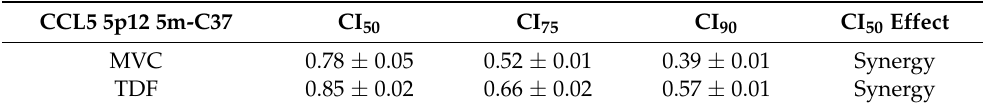
Figure 4. CCL5 5p12 5m-C37 drug combinations. HIV-1 BaL inhibition was evaluated by acute infection assays as described in Figure 3A. CCL5 5p12 5m-C37 was tested in combination with MVC ( A ) and TDF ( B ). The dose-response curves of mixed inhibitors (mix) are referred to CCL5 5p12 5m-C37 ( p -values < 0.0001). Values indicate the means ± SD of two independent experiments performed in triplicate. Table 2. Combination indexes.